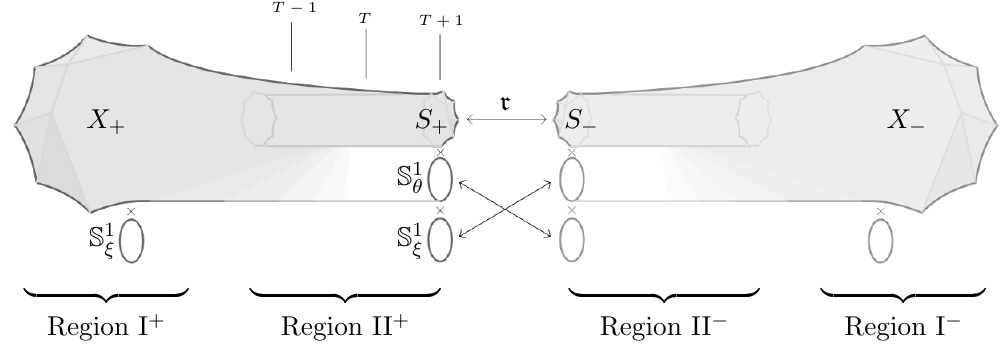
Figure 1 . The twisted connected sum construction of G 2 holonomy